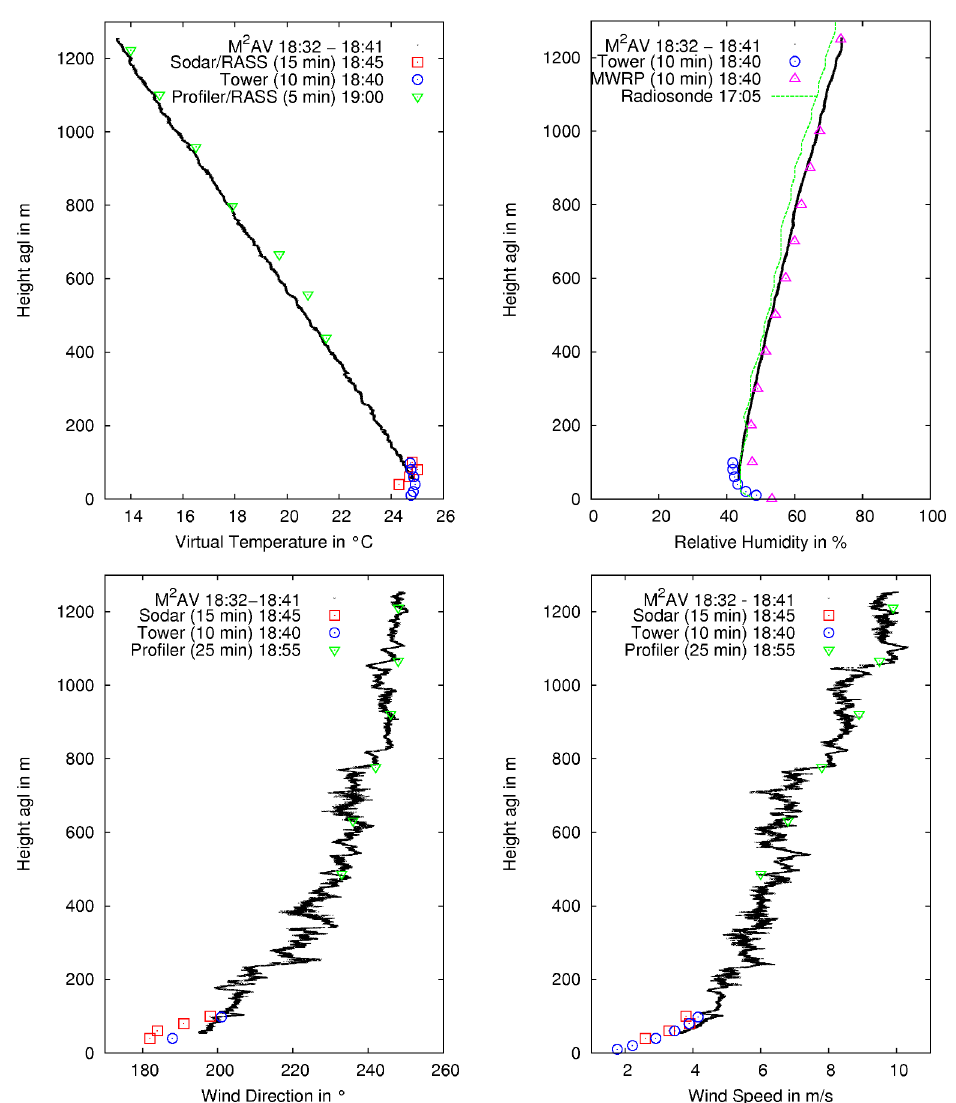
Fig. 10. Vertical profiles measured by wind profiler/RASS, sodar/RASS, tower, MWRP, radiosonde ascent and M 2 AV. These data were collected during the descent of the afternoon flight of the UAV on 21 July 2009 near MOL-RAO. Besides for the M 2 AV, the times indicated in the captions mark the end of the averaging interval